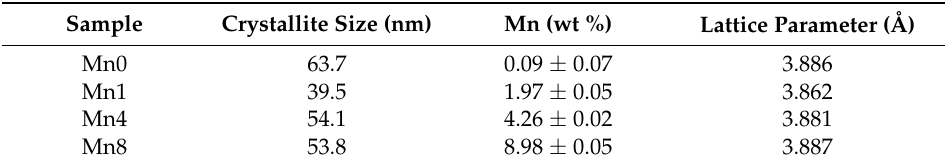
Figure 1. ( a ) X-ray diffractograms and ( b ) zoom-in of the peak located at 32.45 ◦ of catalysts with different contents of Mn synthesized in this work by hydrothermal method and calcined at 600 ◦ C for 5 h. Table 1. Crystallite size calculated by XRD and content of Mn obtained by ICP analysis of catalysts synthesized in this work.